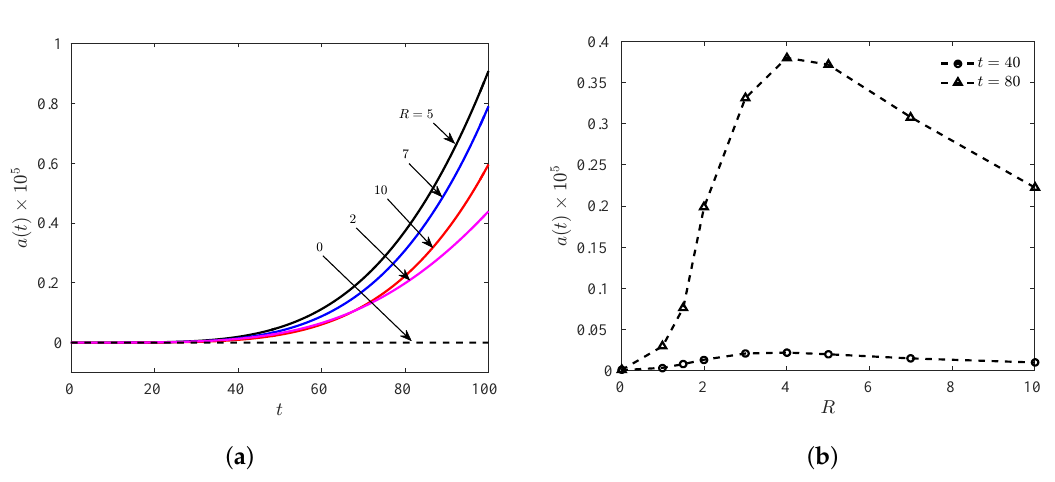
Figure 7. ( a ) Variation of the skewness a ( t ) with time, for different R ; ( b ) a ( t ) at fixed t showing a non-monotonicity with respect to R